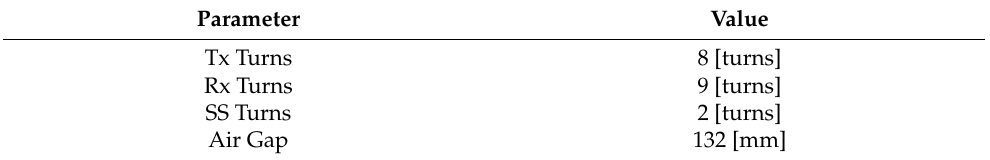
Table 1. Structural parameters.